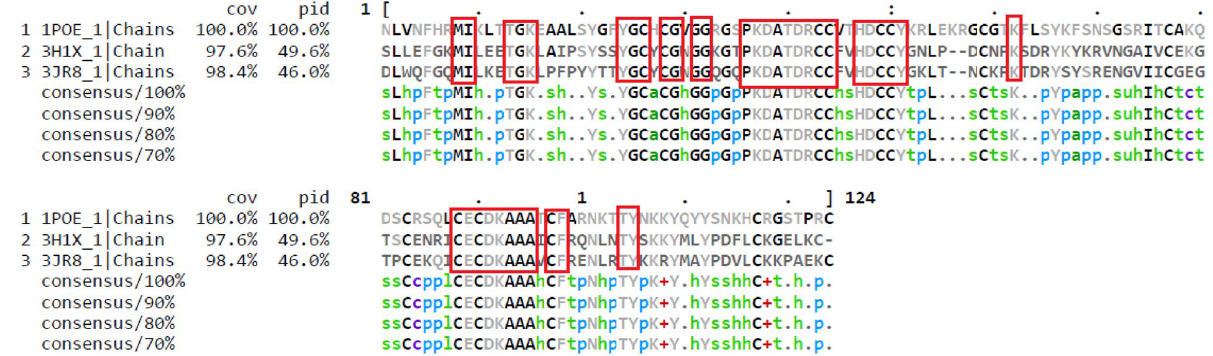
Figure 4. Sequence alignment of human GIIA (1POE), B. jararacussu GIIA (3JR8), and V. russelii GIIA (3H1X): Sequence of 1POE, 3JR8, and 3H1X were obtained from protein data bank and downloaded in fasta format. Alignment was done using Clustal Omega (https:// www. ebi. ac. uk/ Tools/ msa/ clust alo) and amino acid similarities visualized by MView (https:// www. ebi. ac. uk/ Tools/ msa/